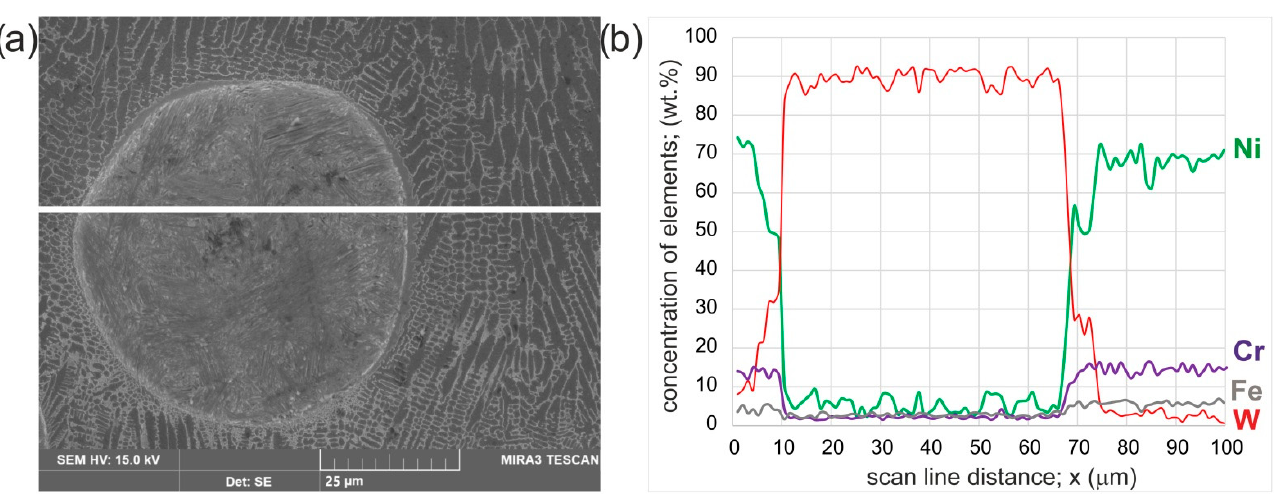
Figure 8. SE image and results of linear X-ray microanalysis performed for a laser-alloyed layer produced with a laser beam power of 1.3 kW; the straight line across a single WC particle ( a ); the concentration of elements across this line ( b ).